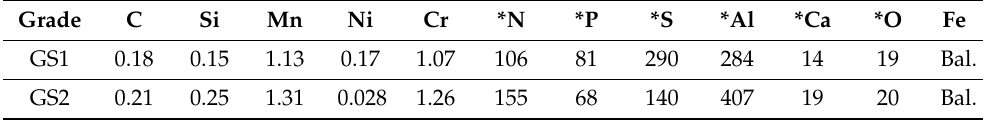
Table 1. Chemical compositions of two gear steel samples